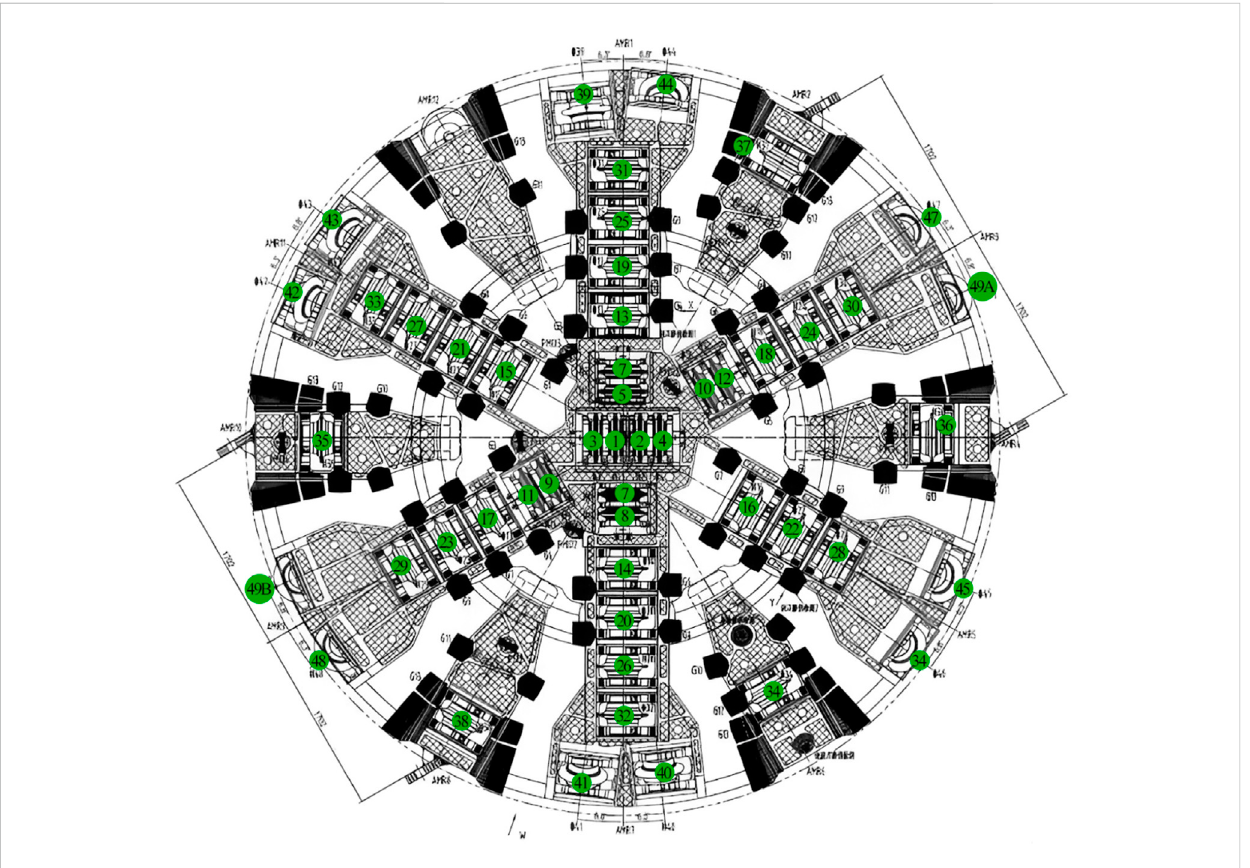
FIGURE 7 Schematic diagram of disc cutters arrangement.